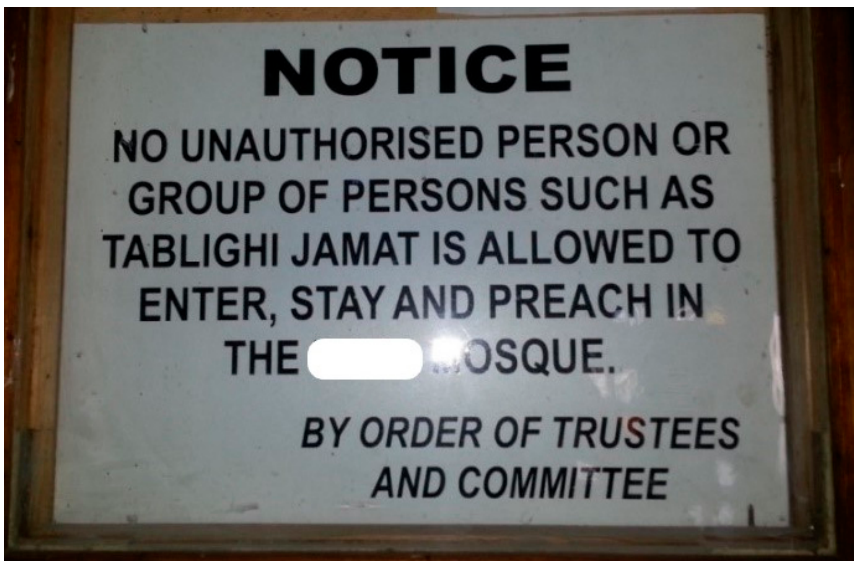
Figure 7. Sign on the noticeboard in a British Barelwi mosque (in terms of the Pakistani context, Ahmad (1991, p. 523) states: “Tablighi Jamaat assemblies are completely banned in the mosques controlled by the Brelvi ulama and their followers”). Source: author’s photo.